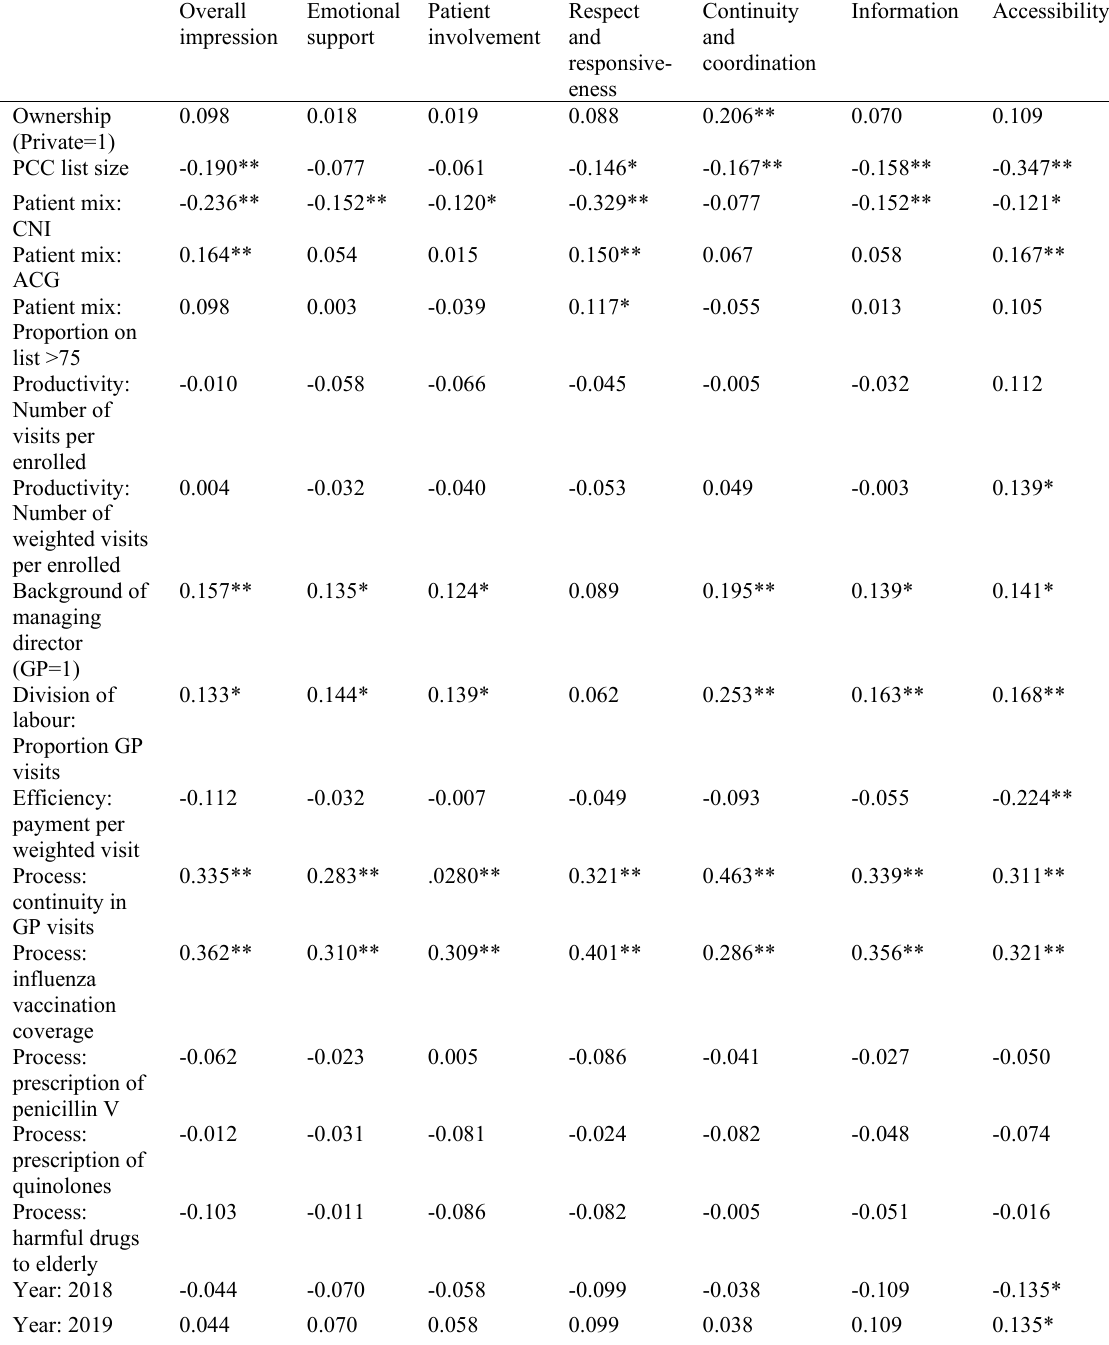
Table 2: Correlations between PREMs and different variables (N=293 PCC year